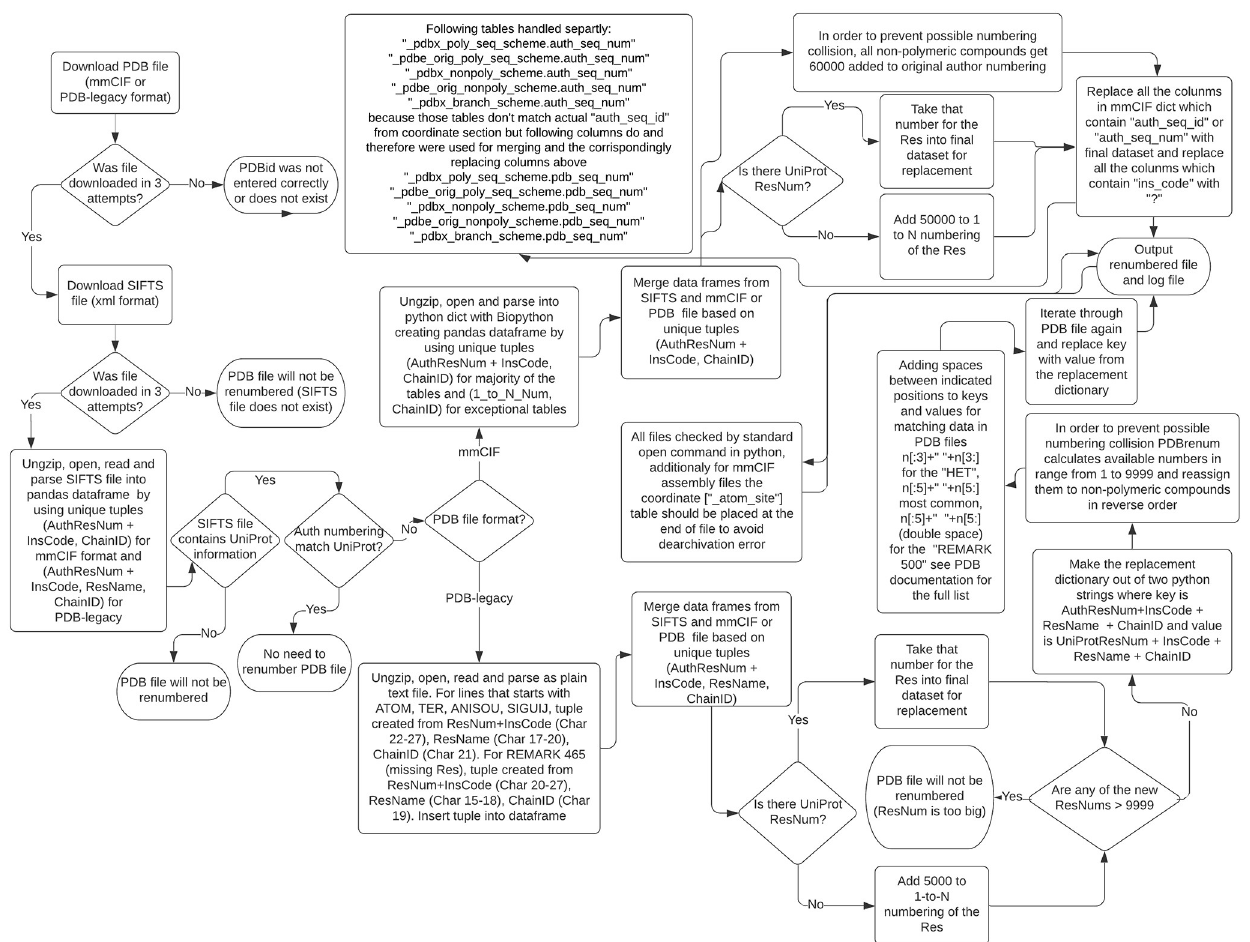
Fig 1. Flow-chart describing basic procedure of